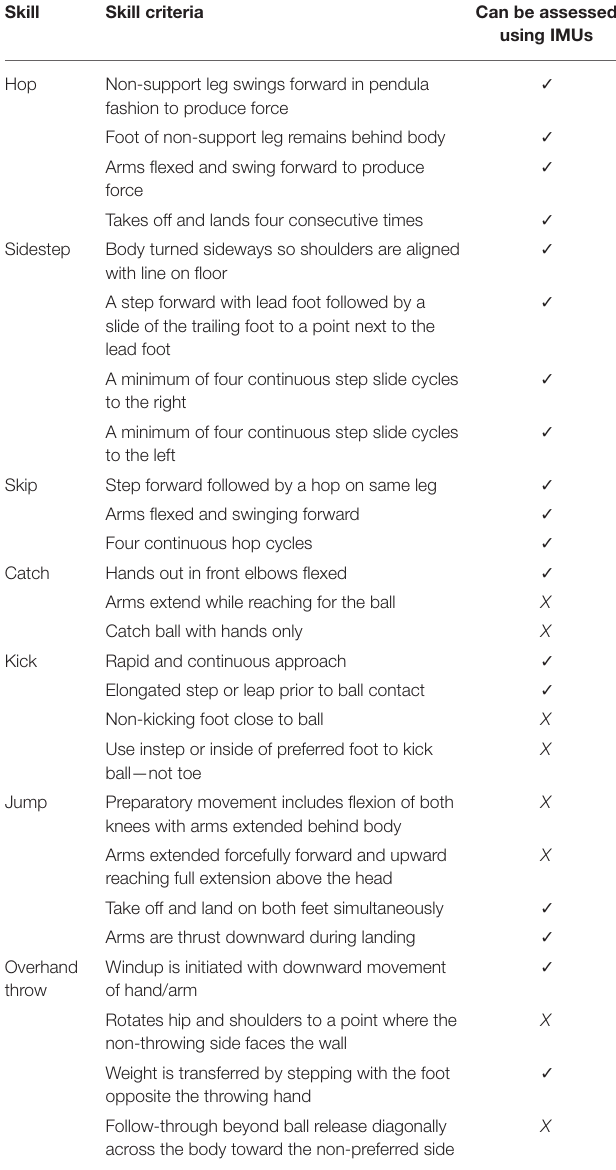
TABLE 1 | The TGMD-3 skill criteria that can and cannot be assessed via IMUs. Skill Skill